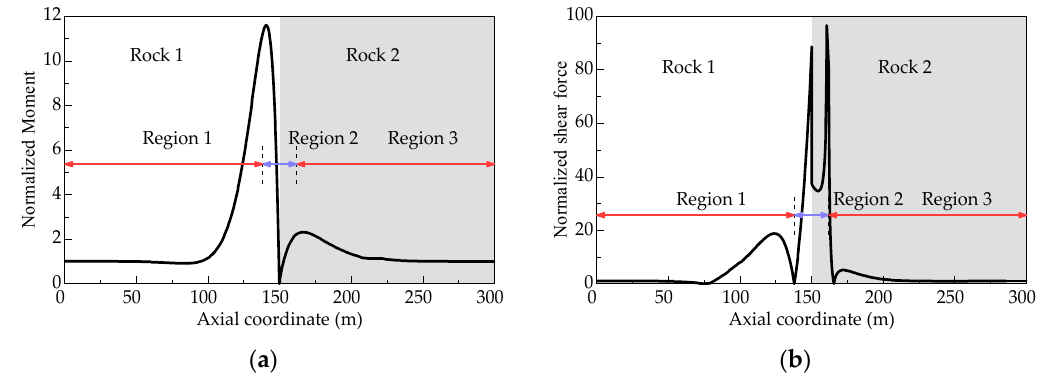
Figure 5. Influences of the soft-hard stratum junction on normalized internal forces. ( a ) Normalized bending moment; ( b ) normalized shear force.